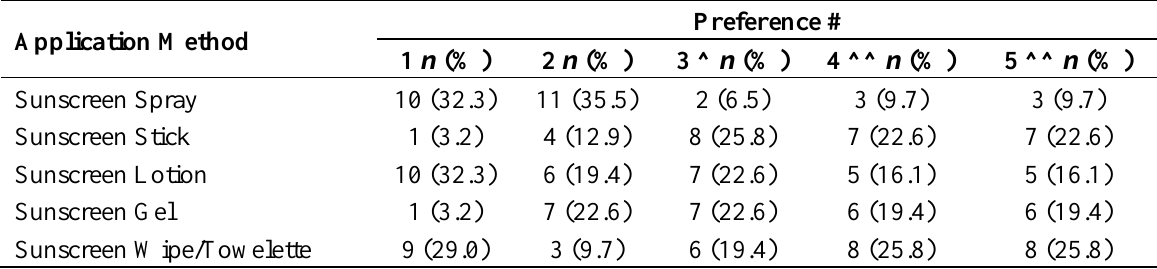
Table 8. Preference of Sunscreen Application